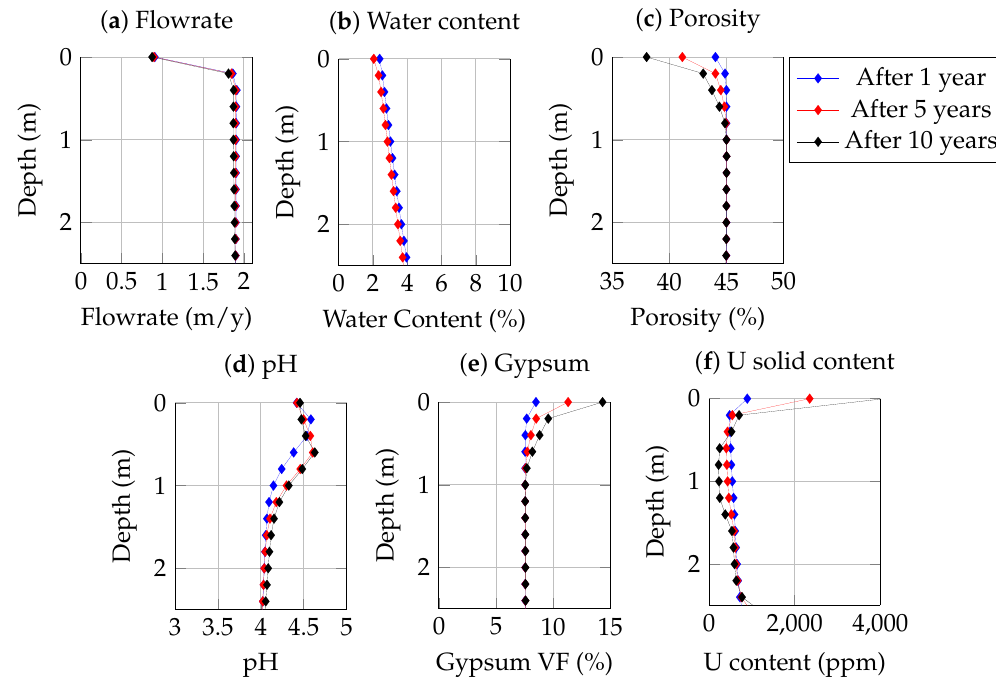
Figure 4. Profile evolution with the time of the column undergoing evaporation. ( a ) Ascending flowrate. ( b ) Water content. ( c ) Porosity. ( d ) pH. ( e ) Gypsum volume fraction. ( f ) U content in the solid